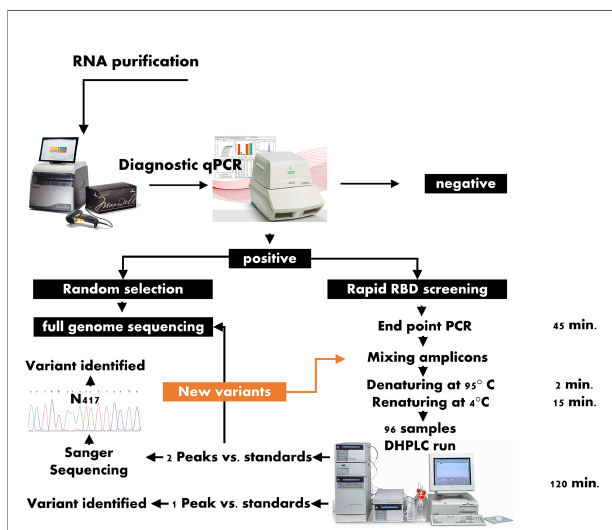
FIGURE 1 | Work fl ow for the rapid screening of the variants of concern. RBD: SARS-CoV-2 Region Binding Domain; DHPLC, Denaturing high- performance liquid chromatography; contrary to the approach represented in the left branch of the scheme, which include the full genome sequencing of a random selection of positive samples, in the work fl ow proposed here, all samples positive to the diagnostic quantitative PCR are submitted for DHPLC screening; those samples forming heteroduplexes when mixed with a reference sample are submitted to either Sanger sequencing of the receptor binding domain or to full genome sequencing or to